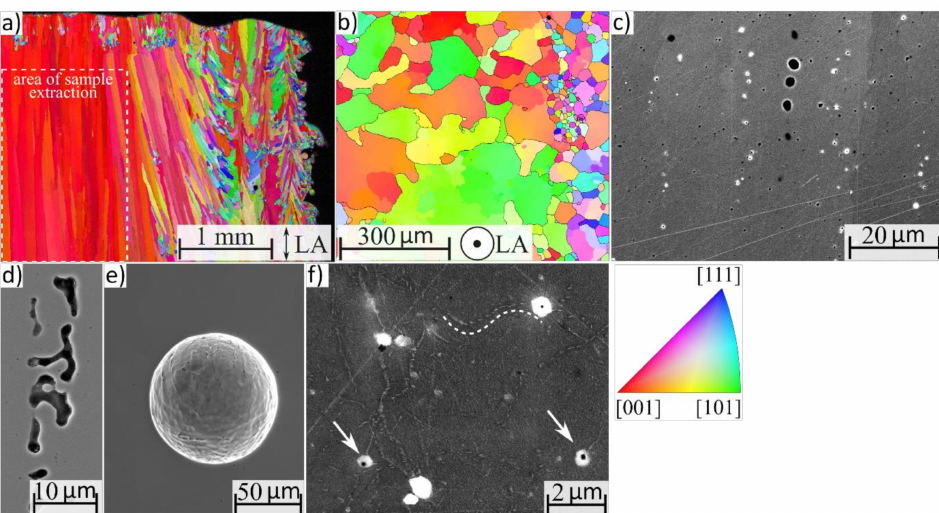
Figure 2. Microstructure of the EBM material. ( a ) EBSD scan of a section extracted parallel to the load axis (LA) with an orientation parallel to the LA in colour code according to the inverse pole figure. ( b ) EBSD scan of a section extracted perpendicular to the LA with an orientation perpendicular to the LA in colour code according to the inverse pole figure. ( c ) Detailed BSE scan parallel to the load axis. ( d ) SE image of shrinkage porosity. ( e ) SE image of gas porosity. ( f ) Magnified BSE scan perpendicular to the load axis showing a needle-like δ -phase along the grain boundaries (e.g., highlighted by the white dashed line) and blocky-like carbides (e.g., highlighted by white